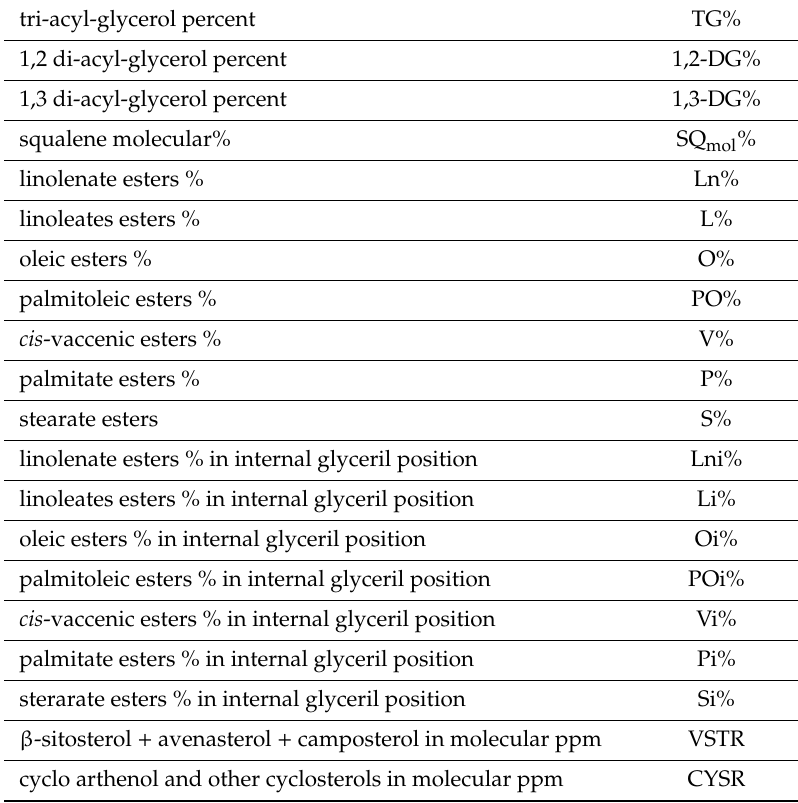
Table 1. Abbreviations used to indicate quantitative